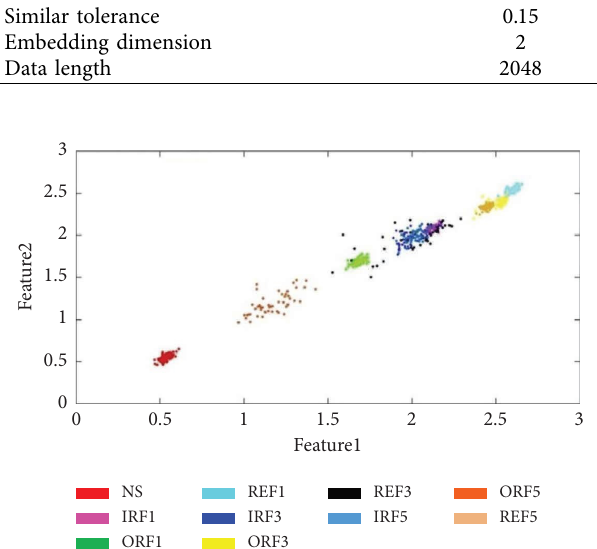
Figure 10: 2-D feature cluster diagram of diferent fault degrees.